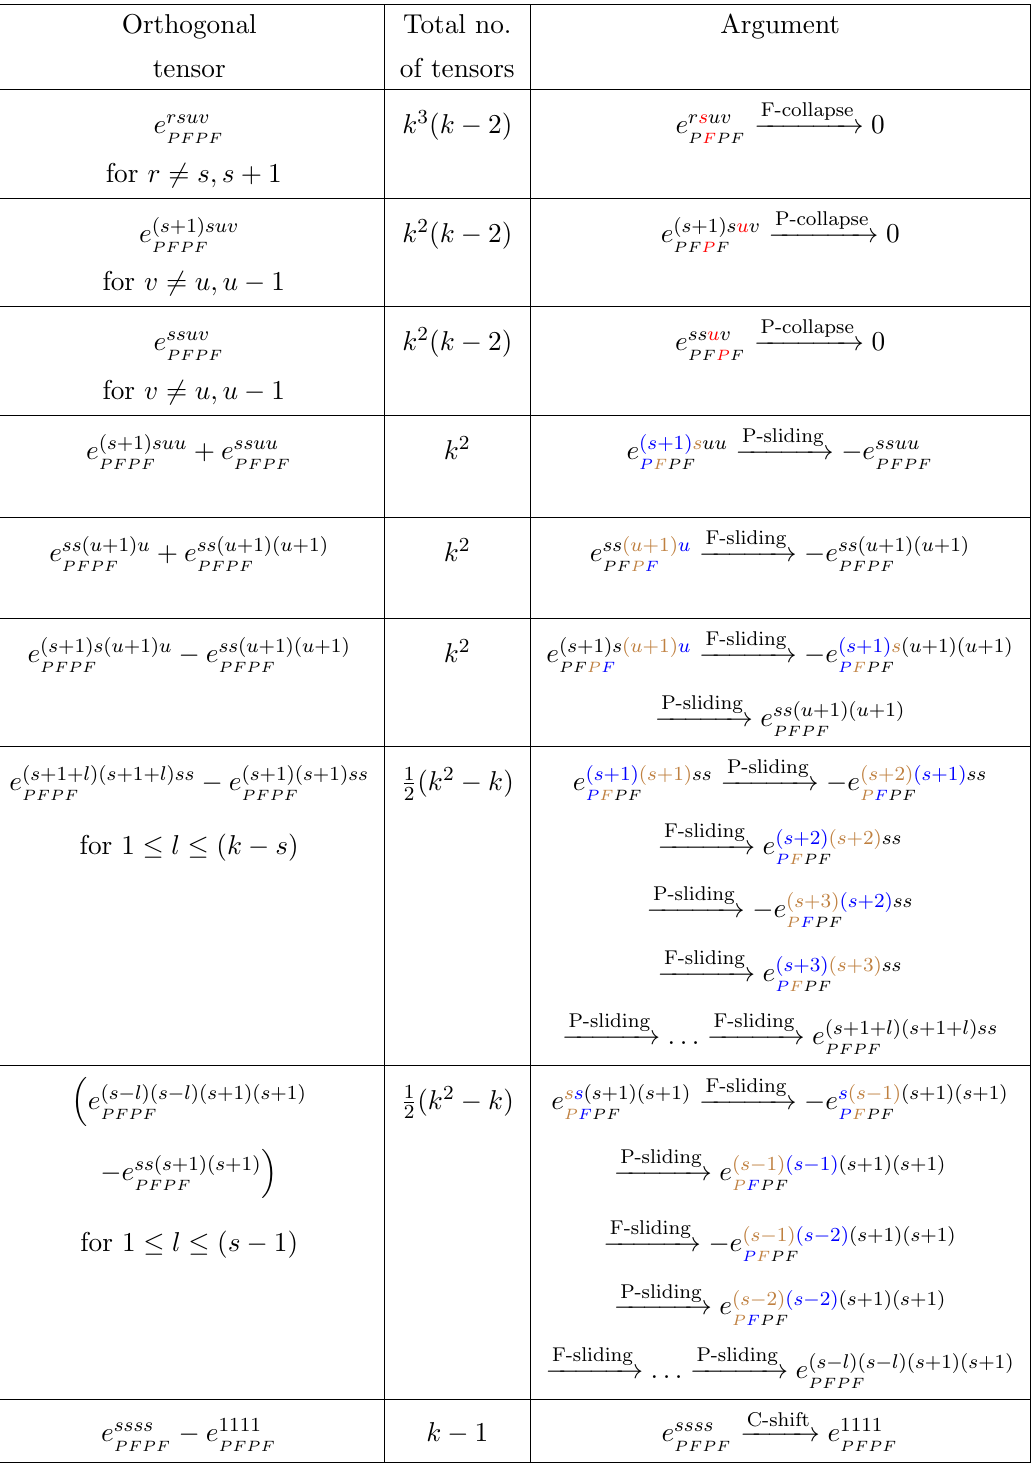
Table 8 . Arguments for the tensors in the PFPF sector orthogonal to the array of 4 point contour